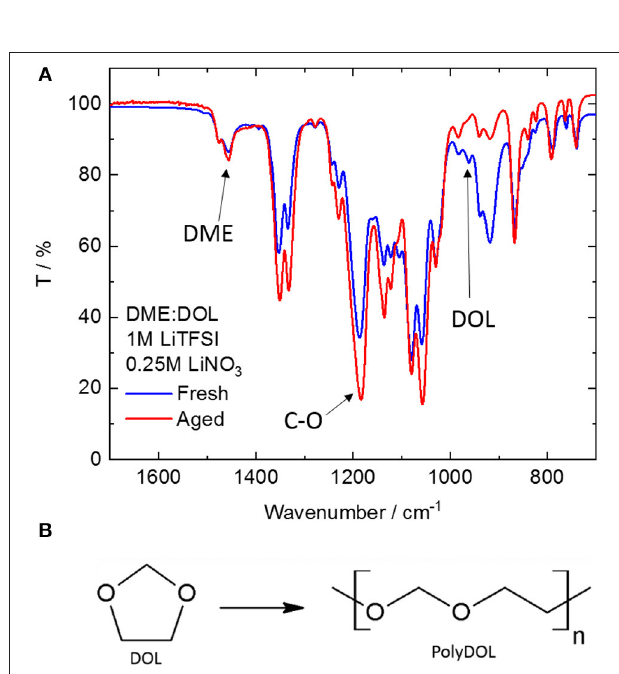
FIGURE 2 | (A) ATR-FTIR spectra of freshly prepared (blue line) and aged (red line). DME, DOL-based electrolyte. (B) Scheme of the polymerization reaction of